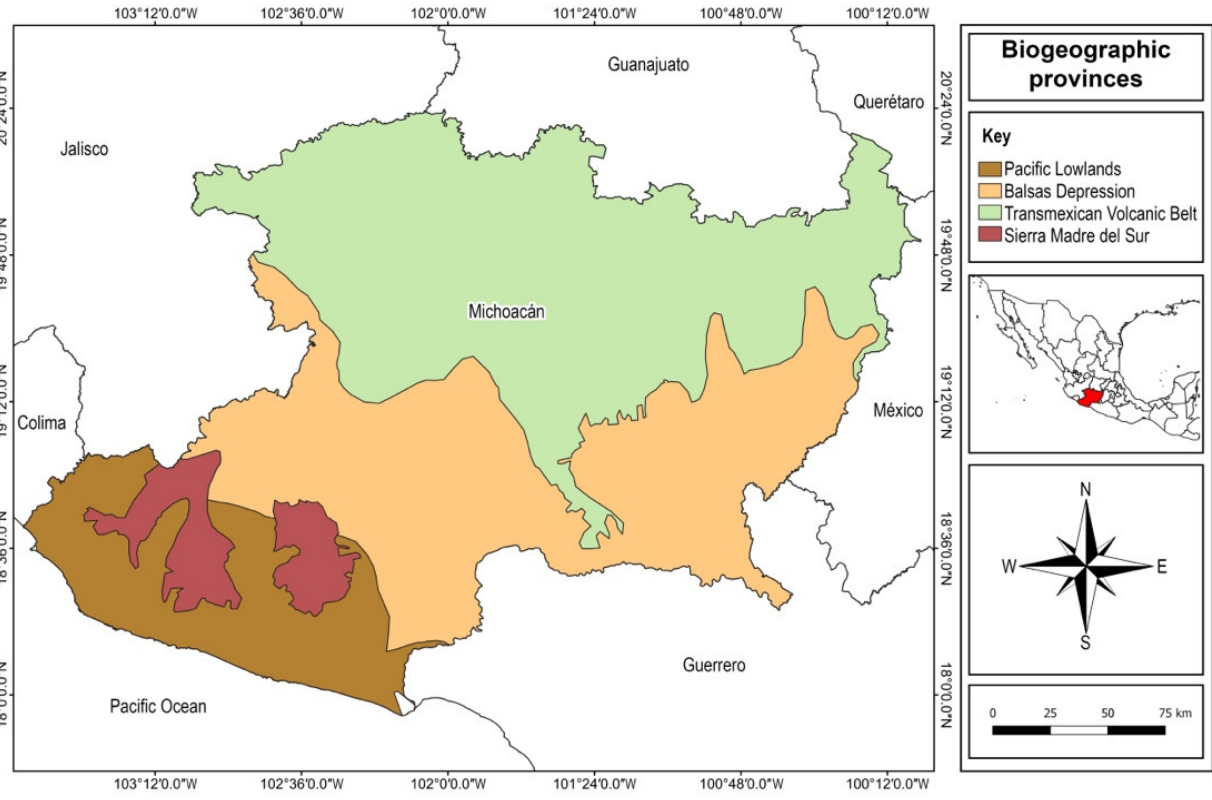
Figure 1. Map of Michoac á n,